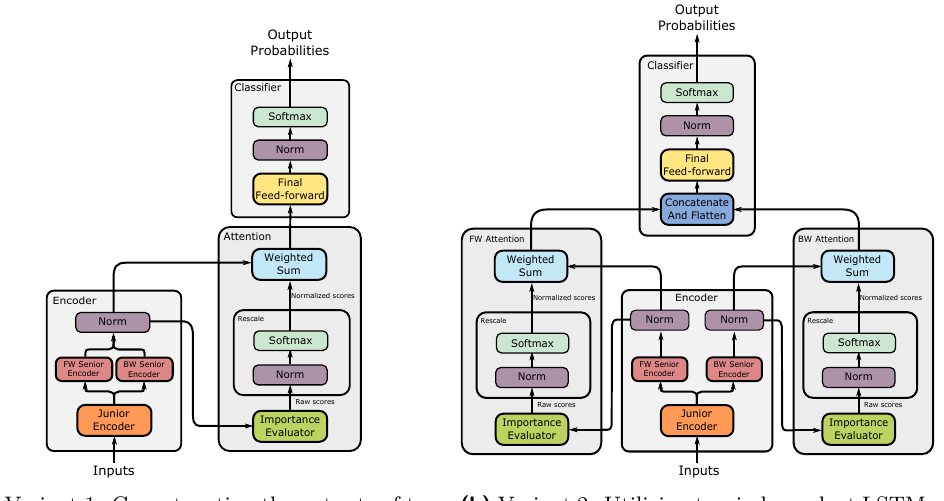
Figure 5: Two variants of our